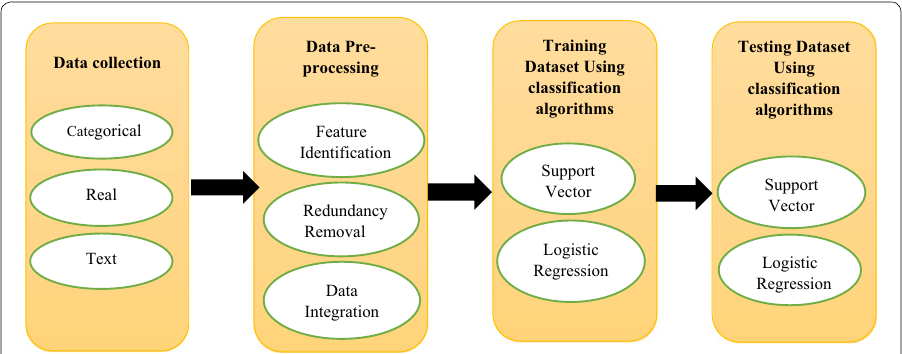
Fig. 1 Product prelaunch prediction System